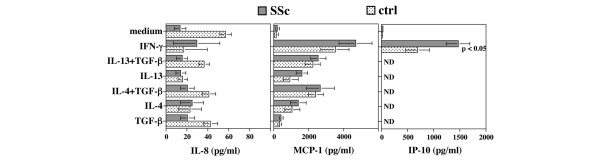
IL-8, MCP-1, and IP-10 production by SSc/control fibroblasts in response to TGF-β and T cell cytokines. Fibroblasts were plated at 2 × 104 cells/well; 72 hours later the culture medium was replaced and TGF-β (10 ng/ml), IFN-γ (1,000 U/ml), IL-4 (10 ng/ml) and IL-13 (10 ng/ml) were added to the wells in triplicate cultures. When used in combination TGF-β, IL-4 and IL-13 were used at 5 ng/ml each. Chemokine levels were determined in the supernatants by enzyme-linked immunosorbent assay upon 48 hours of further culture. The bars represent the mean ± standard error of eight distinct experiments in which SSc and control fibroblasts, matched for passage, age and sex of the donor, were cultured in parallel. IFN, interferon; IL, interleukin; IP, interferon-γ inducible protein; ND, not detectable; MCP, monocyte chemoattractant protein; SSc, systemic sclerosis; TGF, transforming growth factor; Th, T-helper.